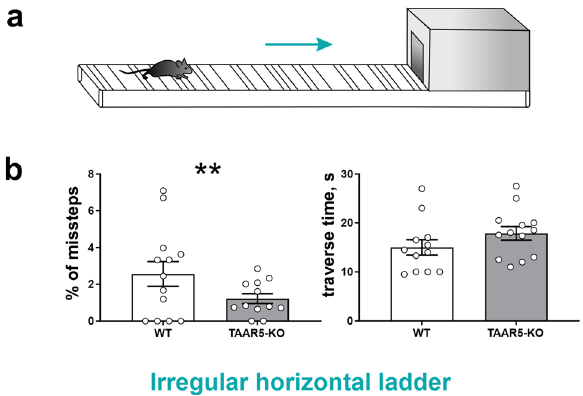
Figure 4. Behavioral testing of complex interlimb coordination required particular attention and concentration in TAAR5-KO and WT mice in the Irregular horizontal ladder test. ( a ) Illustration of the Irregular horizontal ladder test. ( b ) The percentage of missteps and the traverse time. For each animal, the number of missteps was expressed as a percentage of total steps taken by all limbs as they traverse the ladder. Values are presented as mean ± SEM, significance level *P < 0.05, ** P < 0.01.